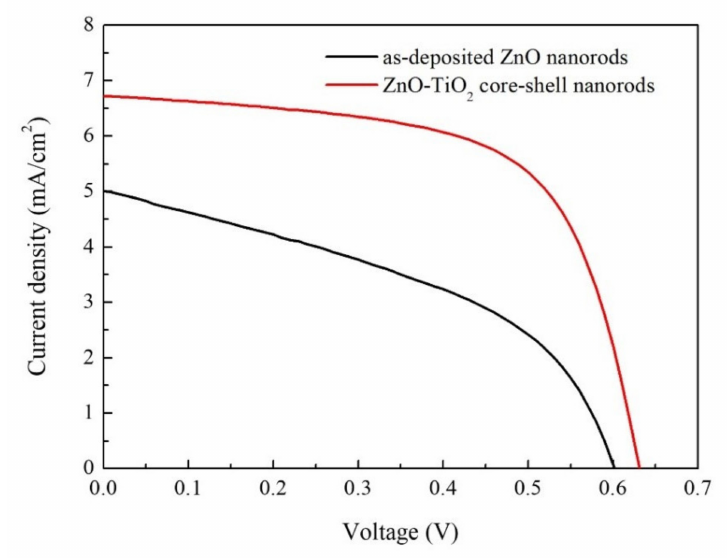
Figure 7. J-V characteristics of demonstrated dye-sensitized solar cells (DSSCs) applying as-deposited ZnO nanorods and ZnO–TiO 2 core–shell nanorods as